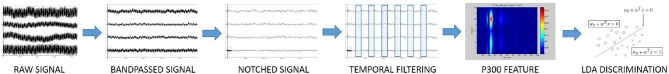
The description of the signal chain.